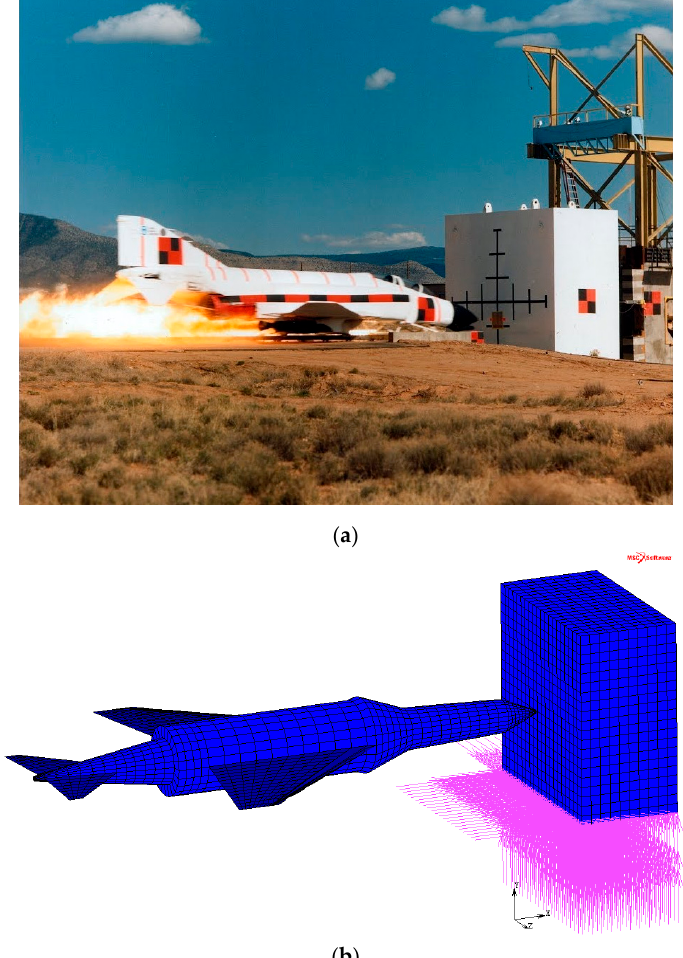
Figure 1. Full-scale aircraft-impact test ( a ) and numerical model ( b ).